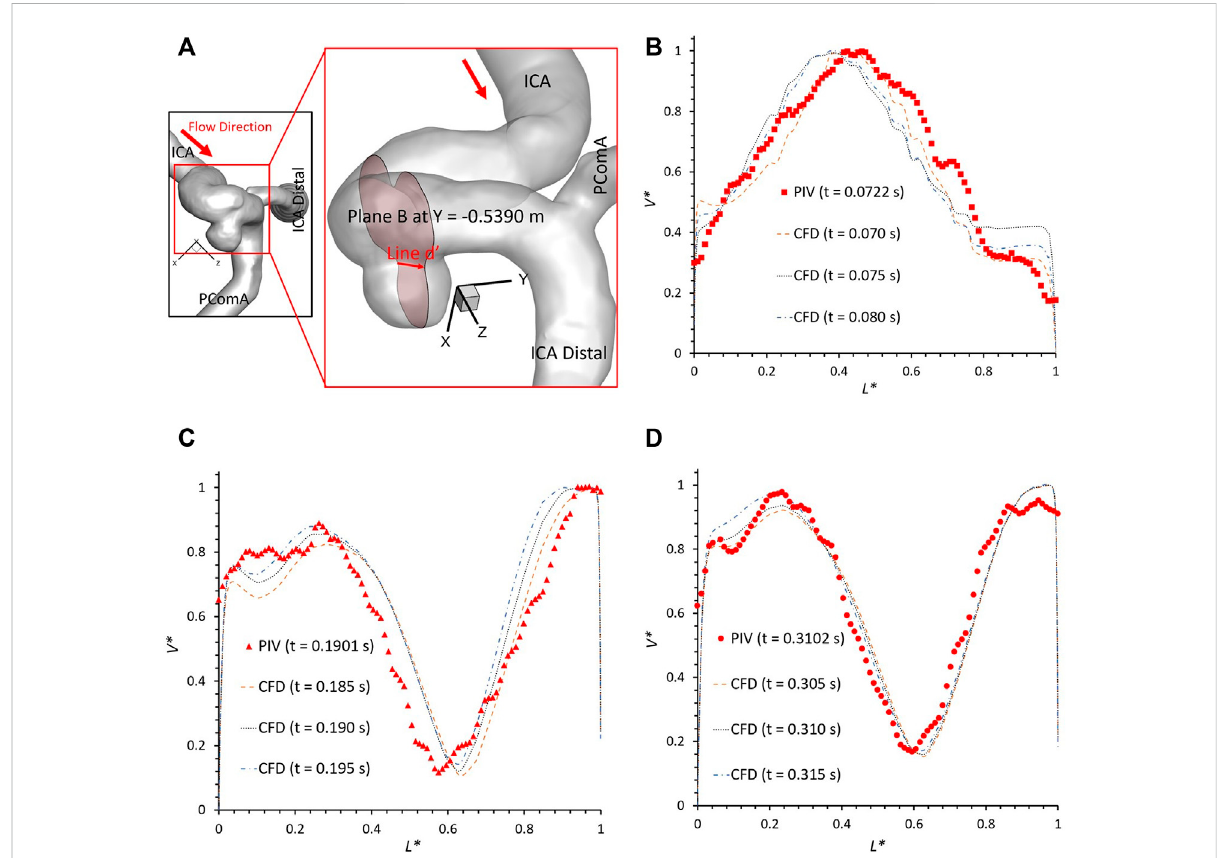
FIGURE 9 Velocitypro fi lecomparisonsatlined ’ oftheplaneB(i.e.,planeY ≈ − 0.5390 maccordingtothecoordinatesinCFD)betweenPIVmeasurements and CFD simulations at different time instants: (A) schematic line d ’ for comparisons, (B) t = 0.0722 s, (C) t = 0.1901 s, and (D) t = 0.3102 s.